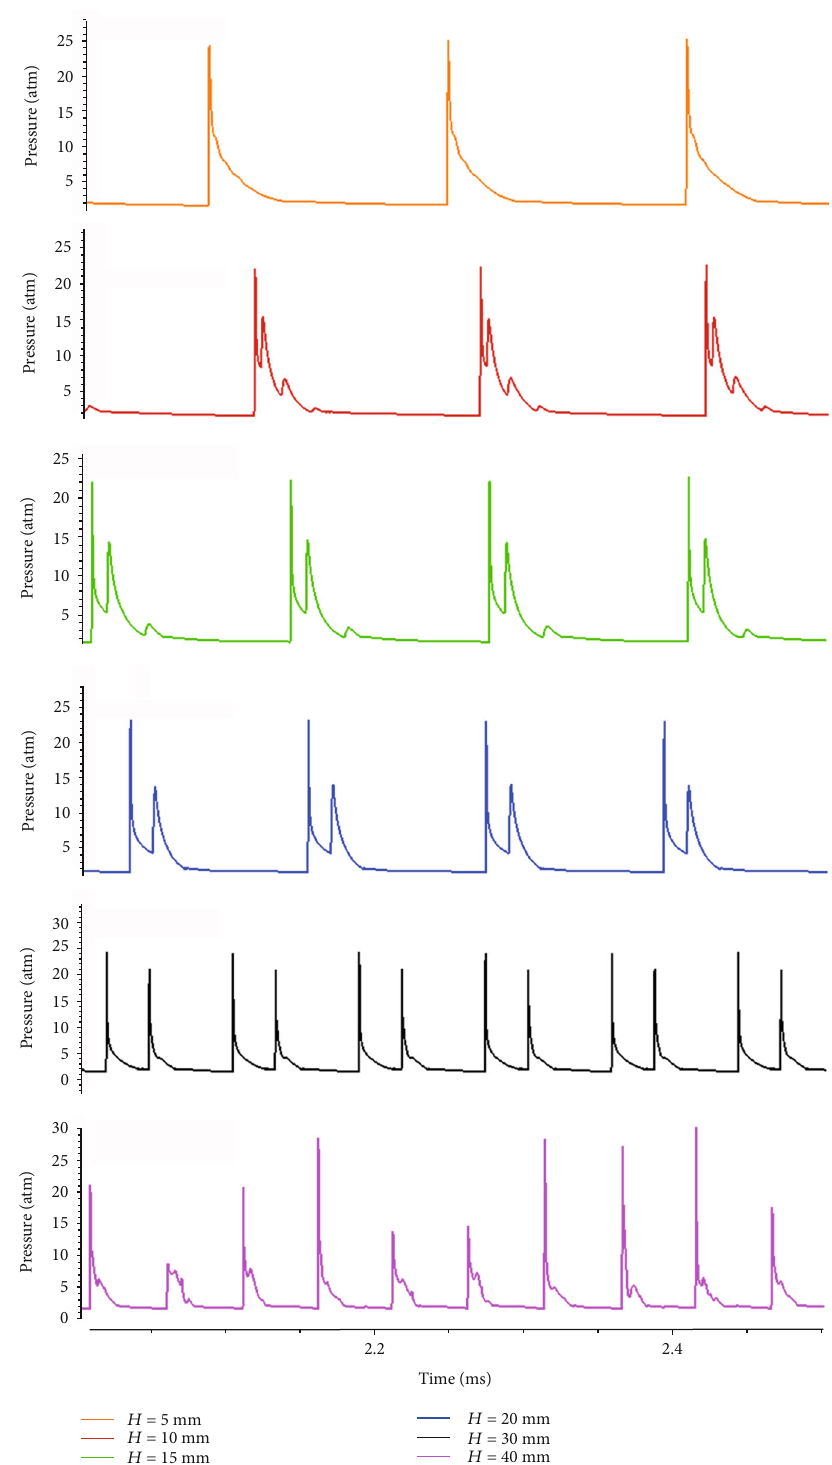
Figure 13: Pressure at the entrance of di ff erent